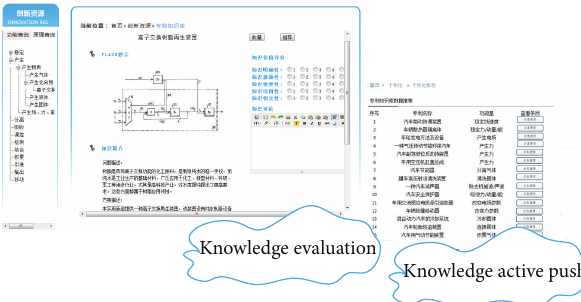
Figure 10: Interface of knowledge evaluation and active